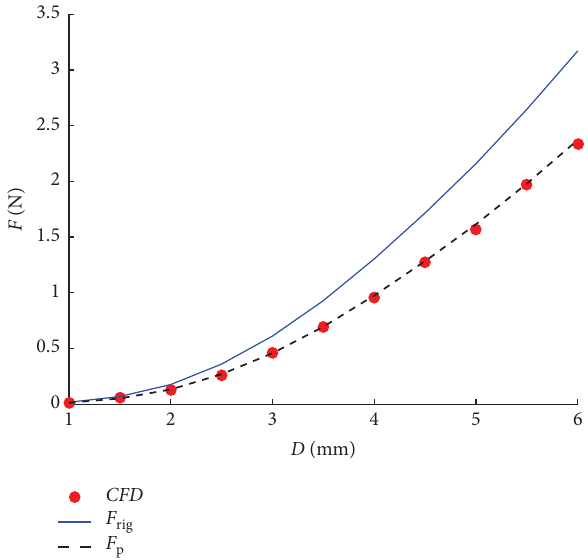
Figure 16: Statistical diagram of raindrop impact